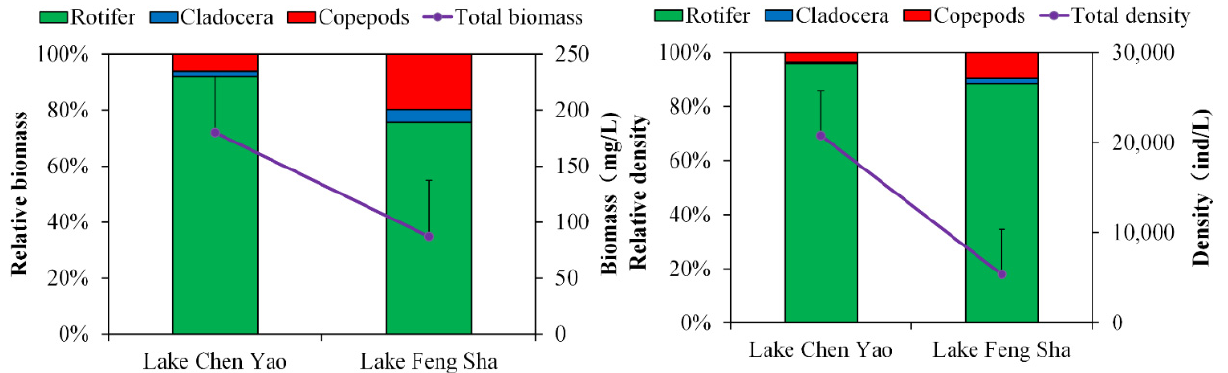
Figure 9. Spatial distribution of zooplankton biomass and density in Lake Chen Yao ( a , b ) and Lake Feng Sha ( c , d ).